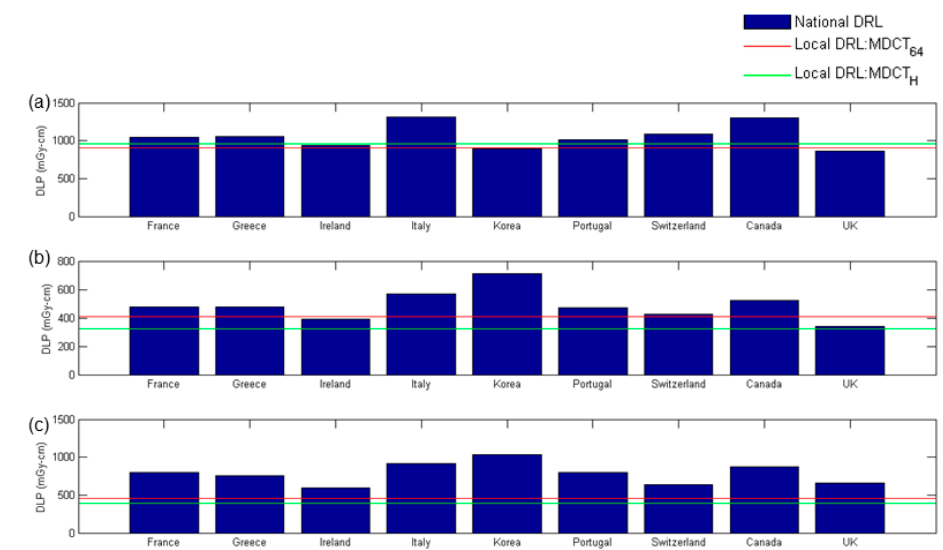
Figure 8. Comparison of local DRLs expressed in terms of the 75th percentile DLP with published national DRLs for adult patients undergoing ( a ) head, ( b ) chest, and ( c ) abdominal scans.